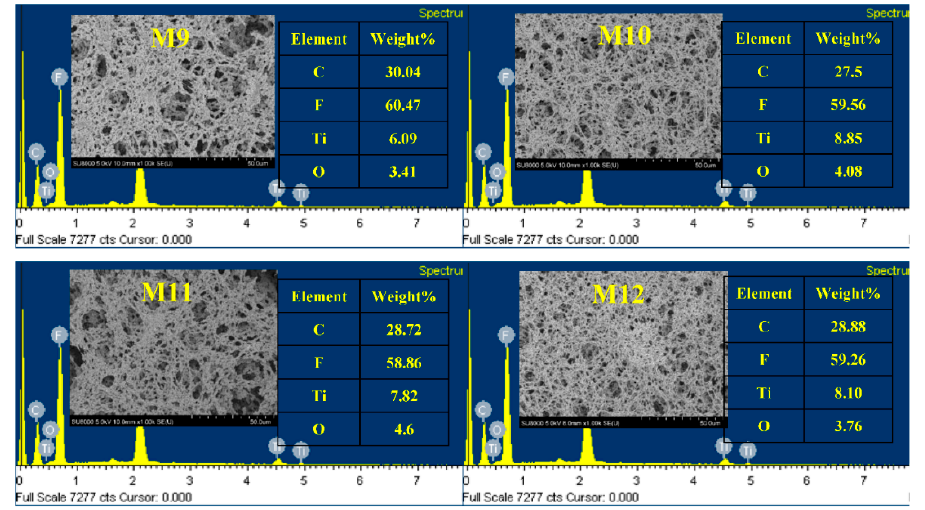
Figure 3. SEM ‐ EDX analysis of PVDF membranes prepared at different polymer, TiO 2 and silane concentrations.